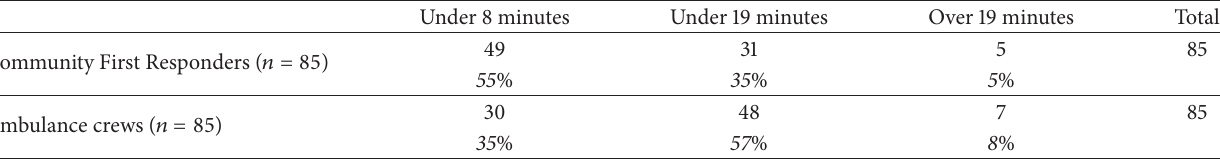
Table2:CFRandambulancecrewresponsetimeperformanceagainstcurrenttargets,showingthelargerproportionofwithin-targetresponse times for CFRs versus ambulance crews. Note that these results are indicative of response time only and do not reflect the target category of the call